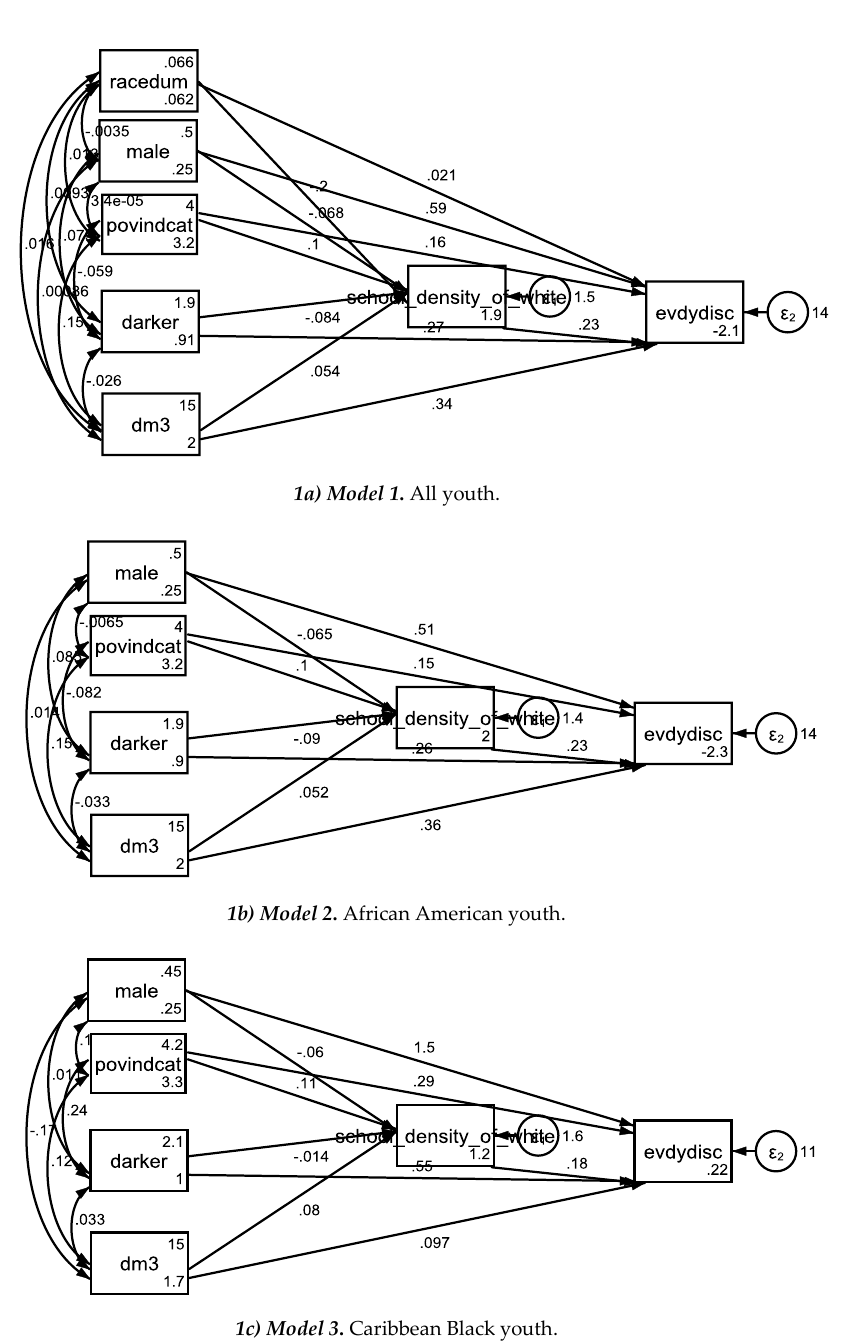
Figure 1. Model 1 to Model 3 in the pooled sample, African American, and Caribbean Black youth.